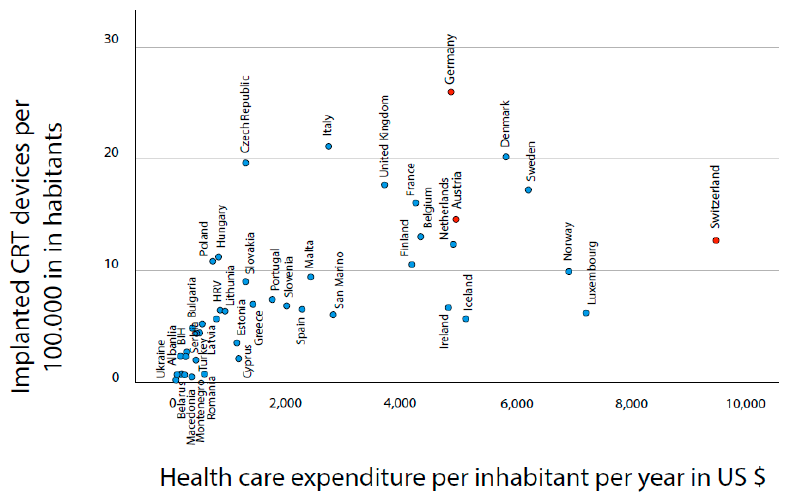
Figure 1. Chart for CRT implantations per 100,000 inhabitants and annual healthcare expenditure per inhabitant in Europe.